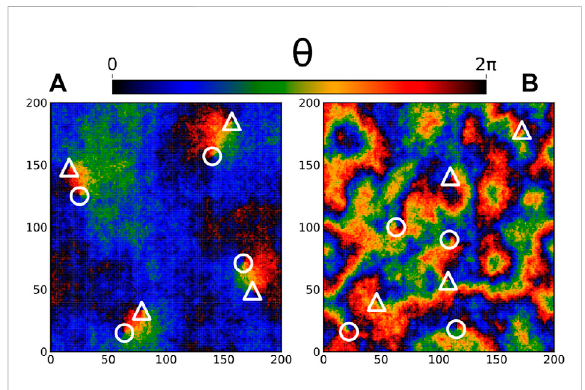
FIGURE 7 Snapshots for m = 1, T = 0.2, (A) σ 2 = 0 and (B) σ 2 = 0.1. The phase of each oscillator is represented by a color scale. Vortices (antivortices) are represented by circles